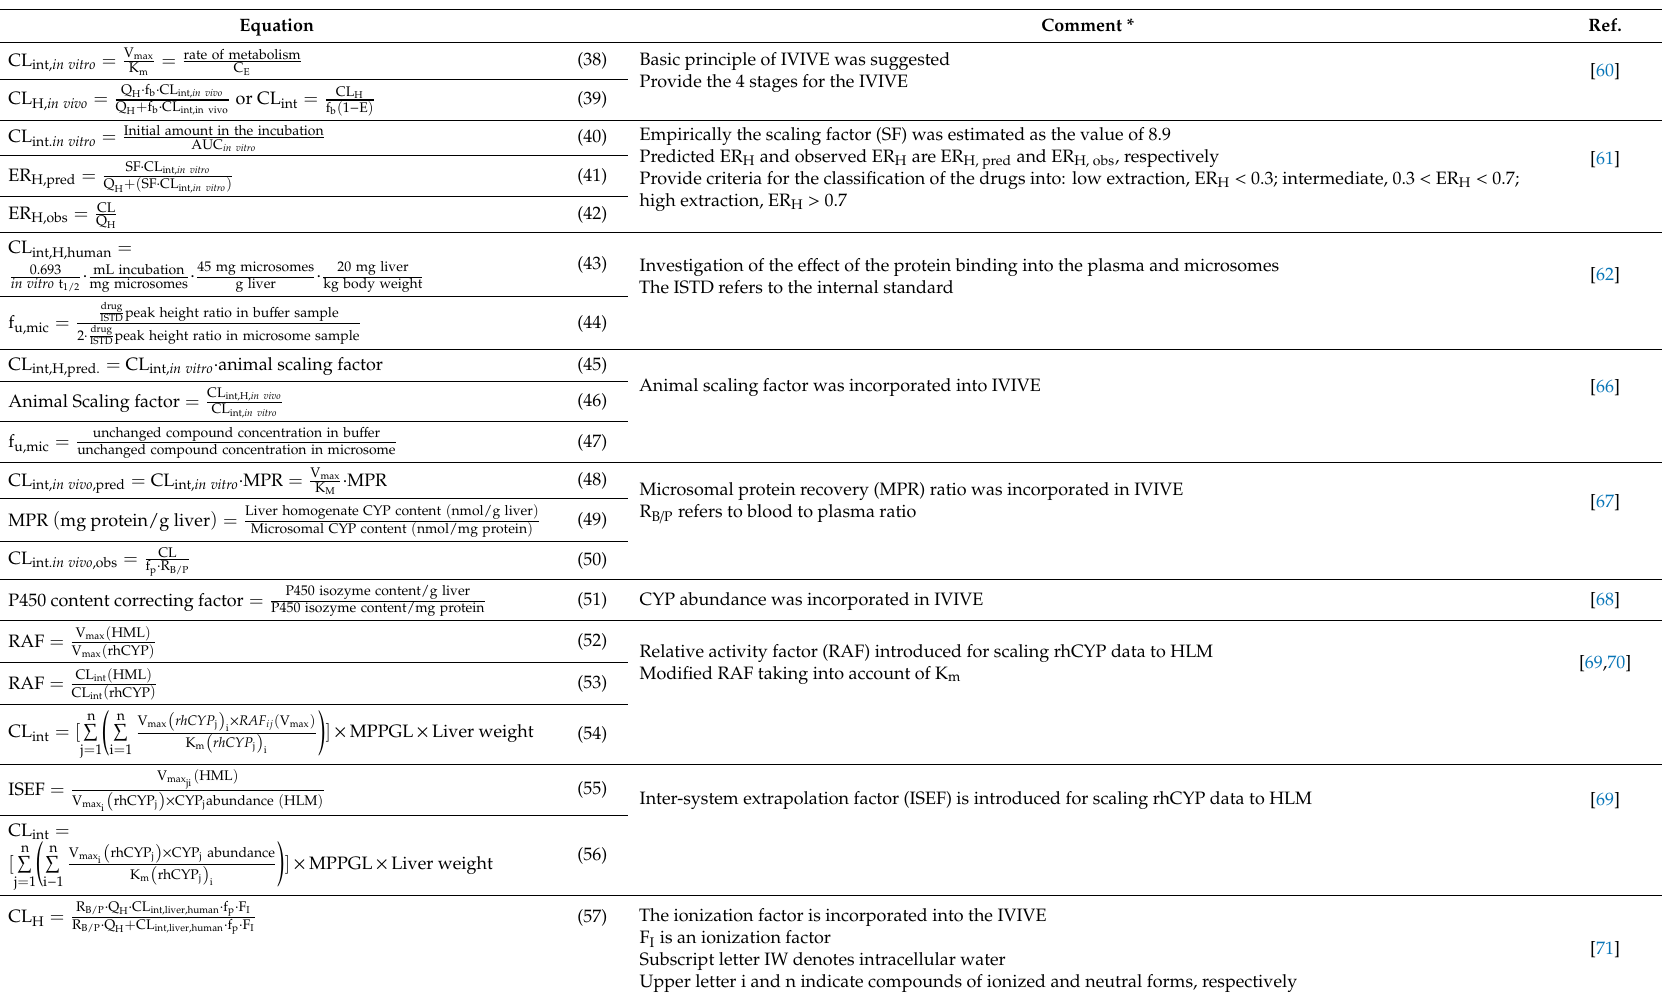
Table 2. Mathematical equations of the IVIVE approach for prediction of clearance from in vitro